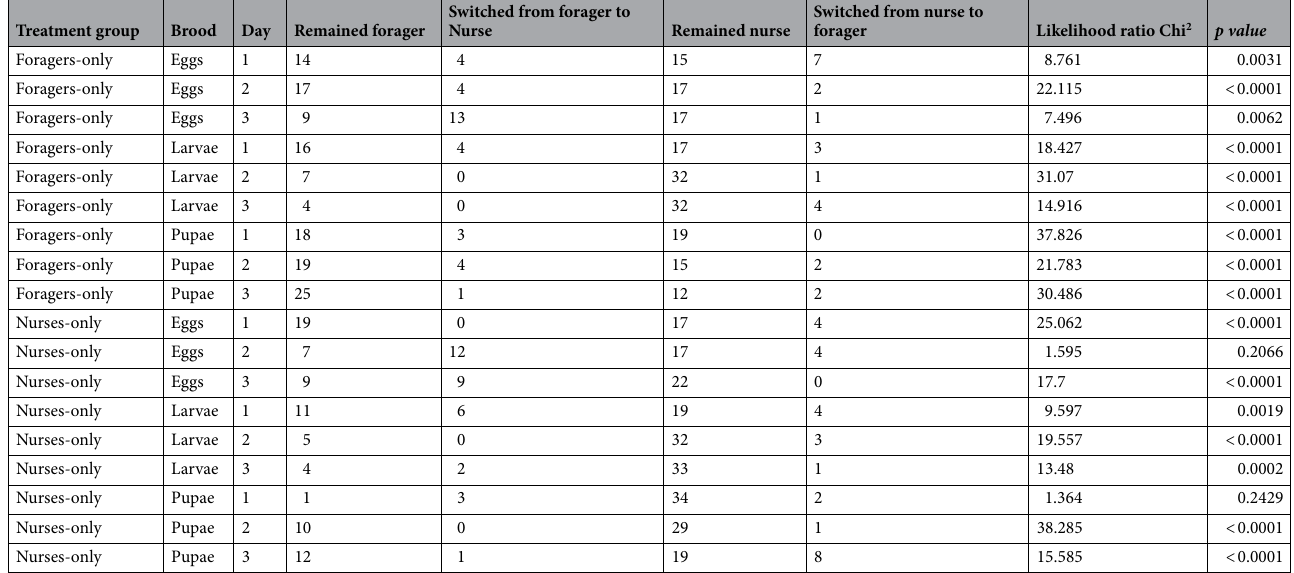
Table 1. Number of workers remaining on task or switching tasks between the observations at time point 1 and time point 5 each day. The reported values are the added tallies for each category of the 4 replicates. X 2 values were estimated using the Likelihood Ratio test on these categorical data. P values of less than 0.05 were considered